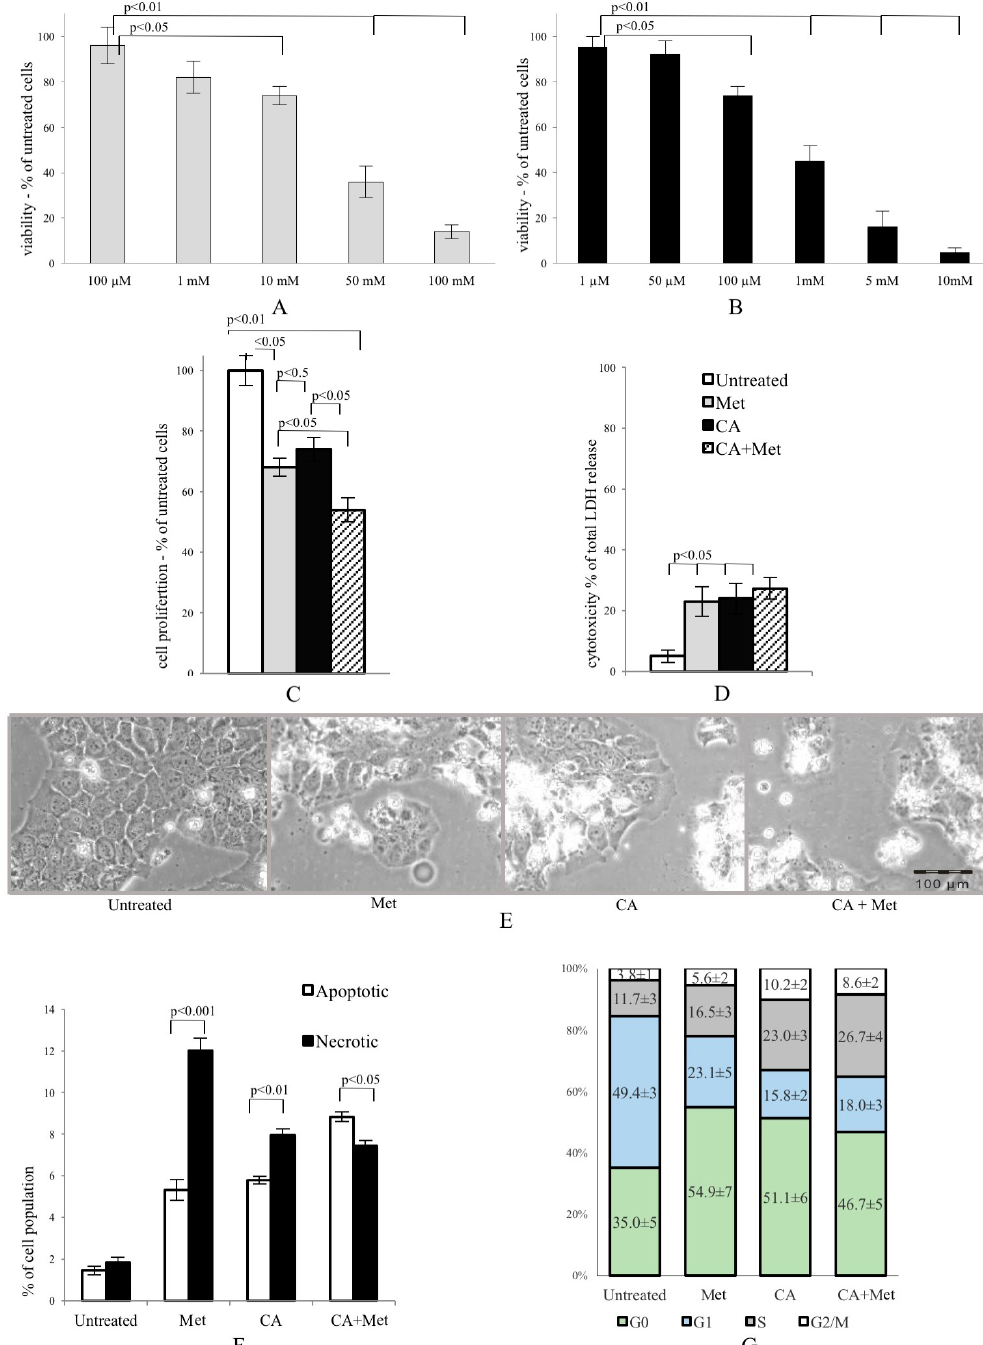
Figure 1. Metformin (Met) and caffeic acid (CA) exert an anti-proliferative effect on HTB-34 human cervical cancer cells. Sensitivity of HTB-34 to Met (( A ) 100 µ M to 100 mM) and CA (( B ) 1 µ M to 10 mM) after 24 h treatment as measured with MTT assay. Effect of Met and CA treatment on ( C ) cell proliferation and ( D ) LDH release; ( E ) Cell culture morphology under phase contrast light microscope after CA (100 µ M), Met (10 mM), and Met/CA treatment. The detrimental effect caused by Met and CA alone is mainly due to necrosis, while combination of Met and CA significantly increase apoptosis in cancer cells ( F ) followed by a shift towards S and G2/M phases of cell cycle in population of treated cells ( G ). Experiments were repeated three times with similar results.